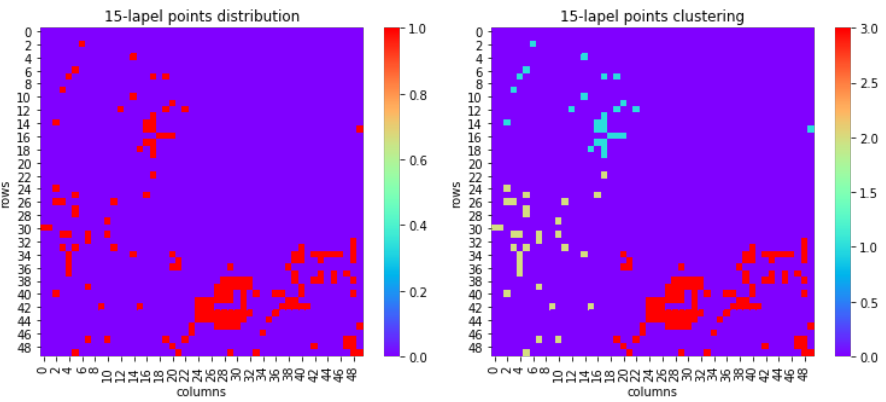
Figure 18. The clustering of the lapel point sequence: ( left ) Distribution of skyline with group of 8 lapel points; and ( right ) the result of the clustering by lapel point sequence and distance. It can be seen that the skyline with lapel number 8 is divided into three